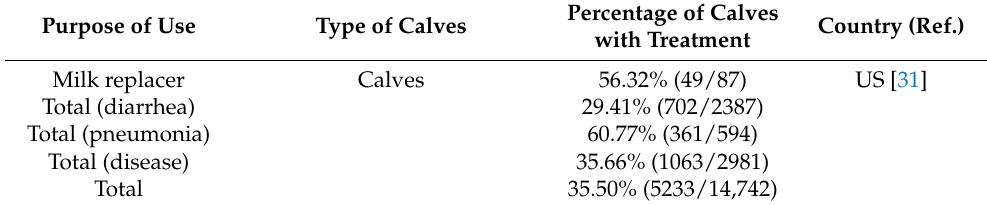
Percentage of Calves Country (Ref.) with Treatment